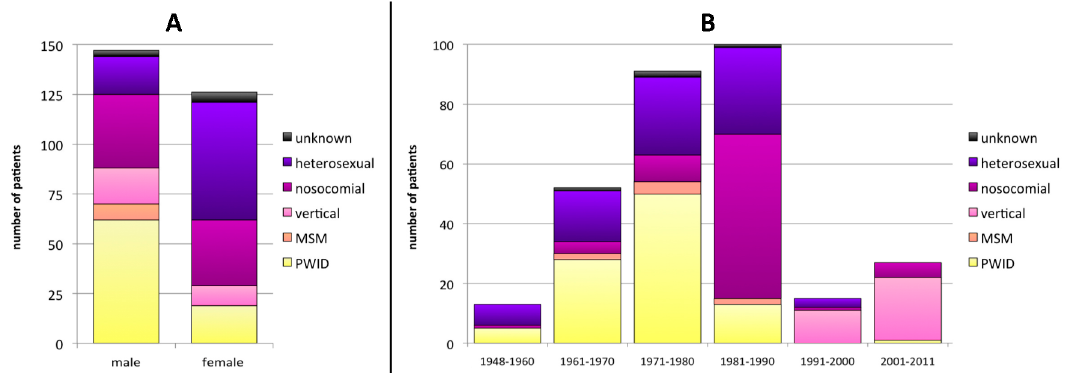
Figure 1. Transmission route distribution according to sex ( A ) and the year of birth ( B ). MSM: men having sex with men; PWID: persons who inject drugs.